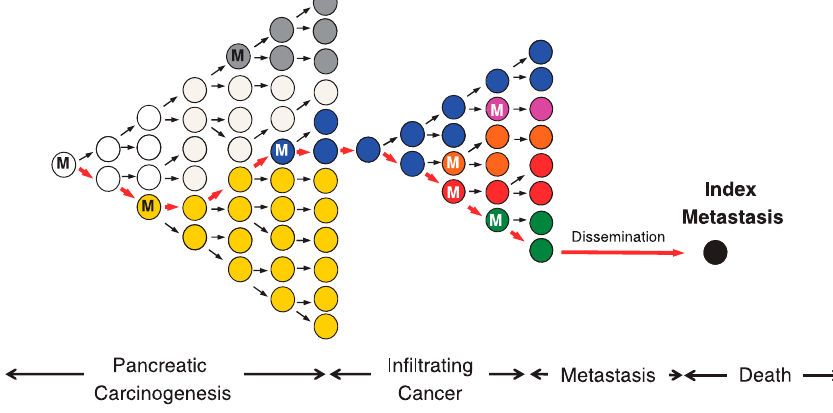
Figure 2. Clonal evolution of pancreatic carcinogenesis and progression. Red arrows indicate the lineage of the index metastasis from its origin in a normal cell. Carcinogenesis begins with an initiating alteration (M) in a normal cell that provides a selective advantage. Before the establishment of fixed cancer cells that are referred to as parental clones, clones with mutations that are beneficial for adapting to the environment are selected by selection pressure and survive. This clonal expansion is expected to generate more than one subclone within a cancer, one of which will give rise to the founder cell (blue clone) that will eventually become the parental clone and hence initiate the infiltrating carcinoma. Once parental clones are established, various spontaneous mutations seem to be accumulated. Even mutations that are not necessarily beneficial in the microenvironment are accumulated. This state refers to intratumor heterogeneity (ITH), which is observed clinically. While abnormal genes are accumulated, subclones that can adapt to the microenvironment at metastatic sites appear and metastasize (black clone). M: Gene mutation. This figure is adapted from Yachida S. et al. [22].